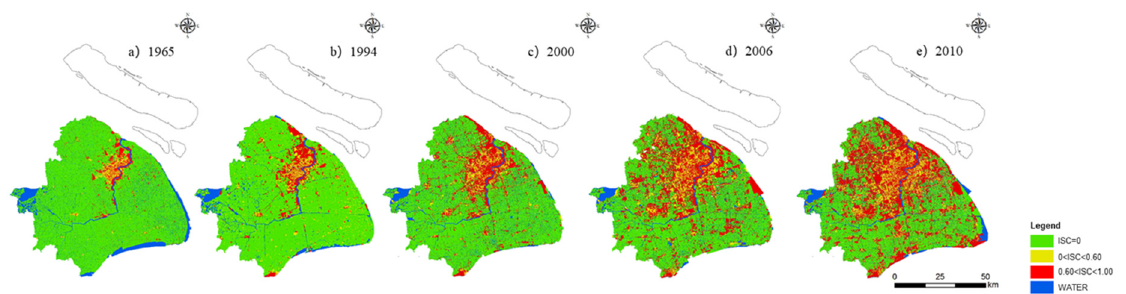
Figure 2. The evolution of spatial distribution of impervious and non-impervious surfaces in Shanghai ( a – e ) (1965–2010). From 1965 to 2010, Shanghai’s impervious surfaces continued to expand from the city center to surround-ing suburbs.